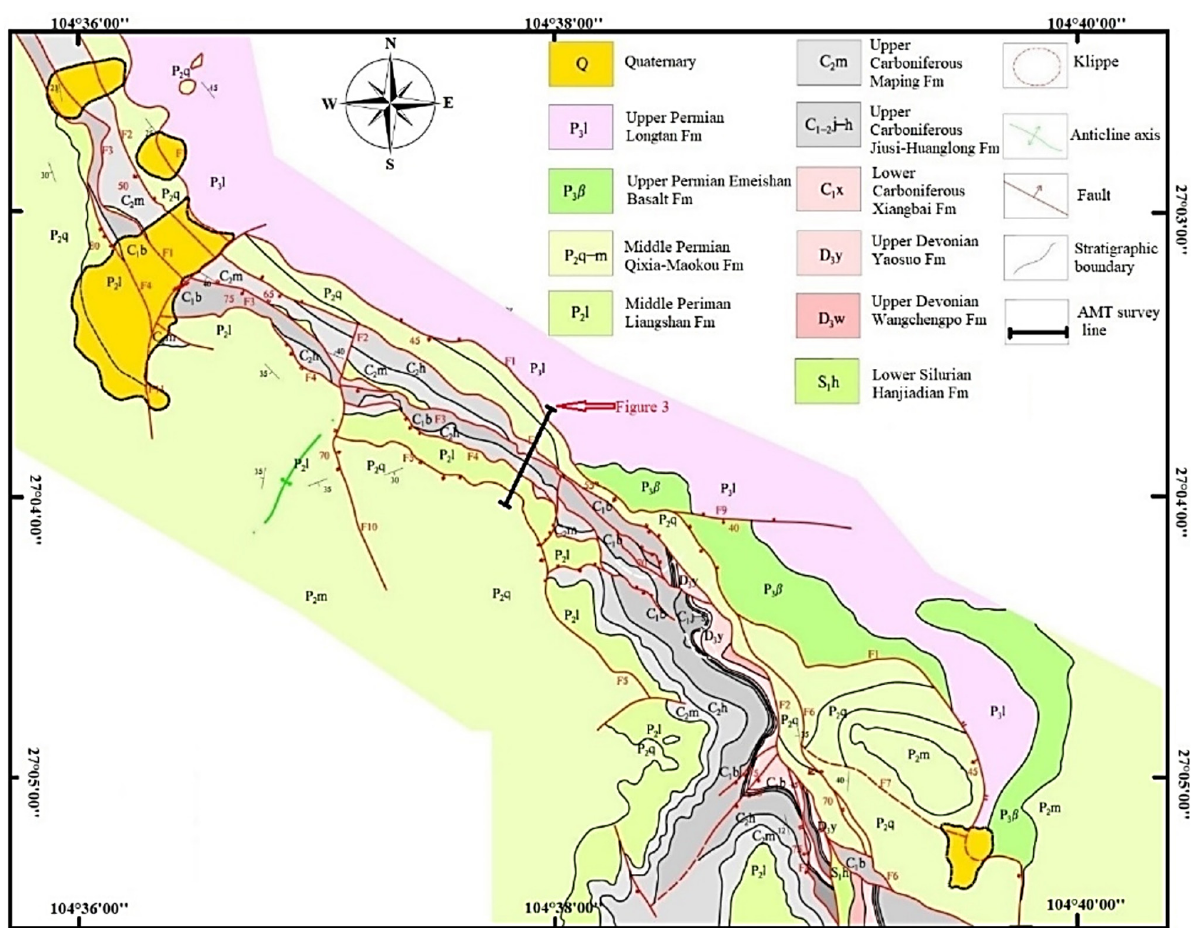
Figure 2. Geological map of Zhugongtang orefield with AMT survey line on top of an interpretation of the geology. Fm: Formation.